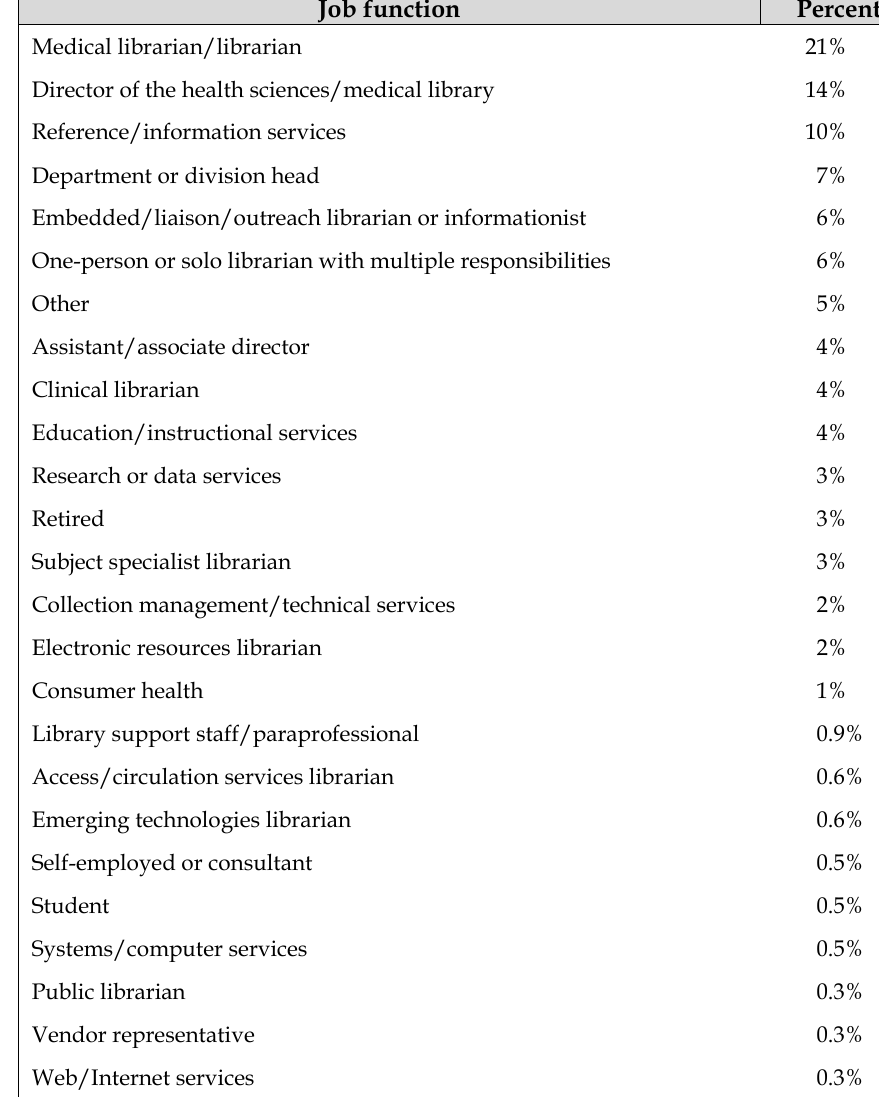
Table 1 Job function by percentage